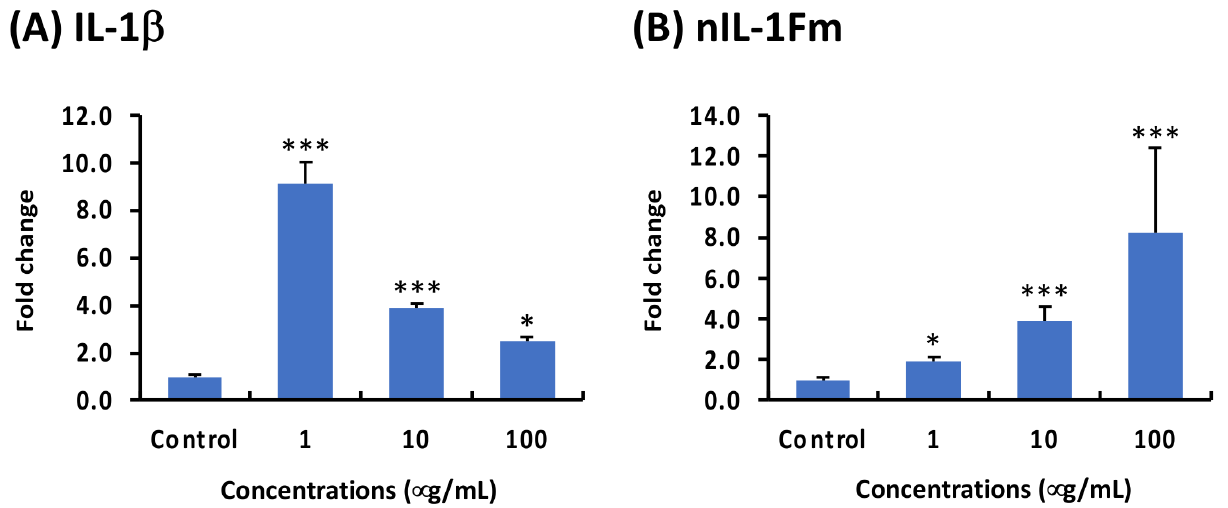
Figure 8. Modulation of IL-1 β ( A ) and nIL-1Fm ( B ) gene expression in PBLs by LPS. The cells were stimulated with different immunostimulants, and medium as a control. The expression was conducted by qRT-PCR. The fold change in comparison to the control was presented as the expression levels were normalized by β -actin. The results are presented as mean + SEM. One-way analysis of variance was used to statistically compare the observed mRNA levels (* p < 0.05, *** p <